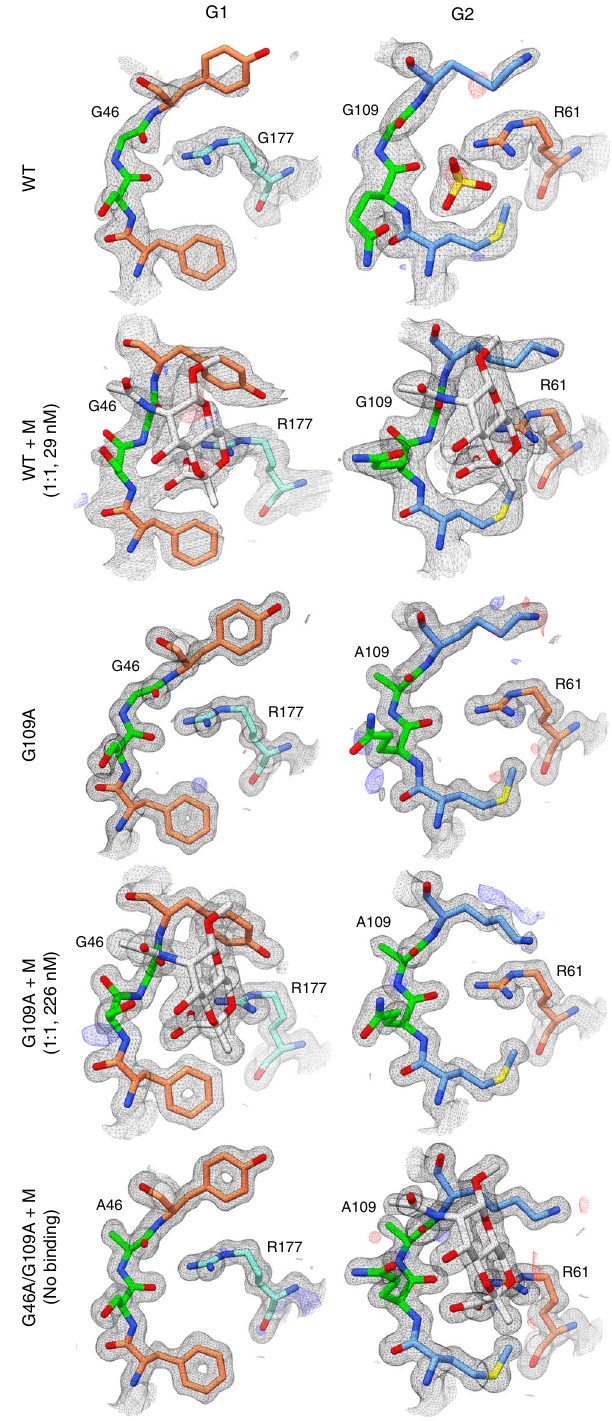
Fig. 4 SLH-Gly29 backbone fl ip. 2Fo – Fc electron density maps contoured to 1 σ (black) and Fo – Fc maps contoured to 3 σ (blue) and − 3 σ (red) are shown for residues SLH-27 to SLH-30 and SLH-Arg43 in groove 1 (G1) and groove (G2) of SpaA SLH structures. Residues are colored according to SLH domain as in Fig. 3, with SLH-28 and SLH-29 in green to highlight the backbone fl ip. WT wild-type SpaA SLH , M monosaccharide ligand, G109A SpaA SLH /G109A single mutant, G46A/G109A SpaA SLH /G46A/G109A double mutant. Monosaccharide ligand and corresponding electron density are shown for structures where density was observed, and binding stoichiometry and K D as determined by ITC are